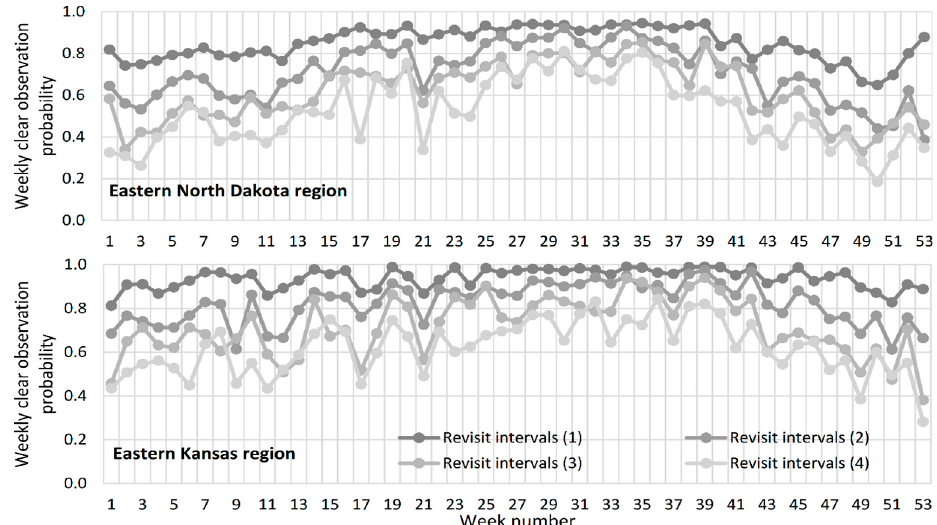
Figure 12. Probability of getting at least one weekly clear observation under different revisit intervals (days), based on quality information from MODIS daily data. (days), based on quality information from MODIS daily